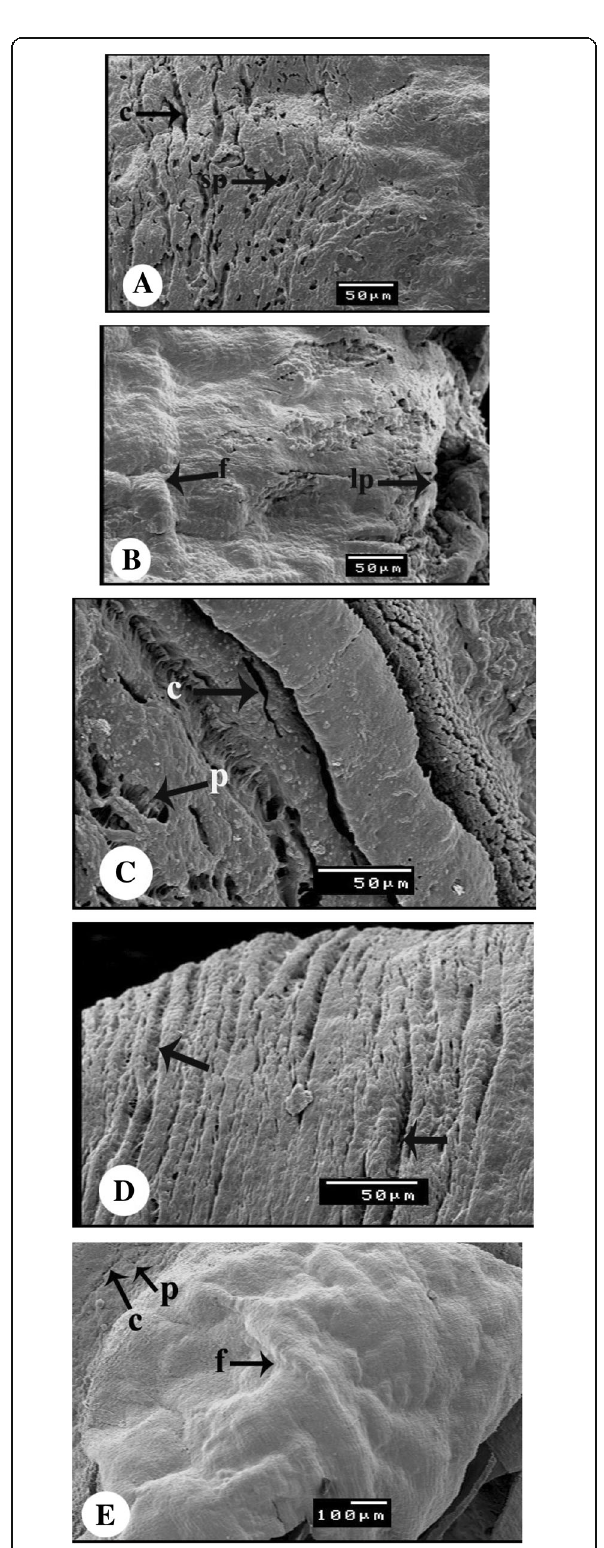
Fig. 2 A , B Scanning electron micrograph of the outer surface of mantle of unexposed snails showing A cracks (c) and small pores (sp), B folds (f), and large pores (lp). C , D Scanning electron microgrph of outer surface of the mantle of snails exposed to UV-A radiation for 3 h for two successive days showing C crack (c) and pore (p). D Deep folds (arrows). E Scanning electron micrograph of outer surface of the mantle of snails exposed to UV-A radiation for 3 h for three successive days shows pore (p), crack (c), and shallow folds